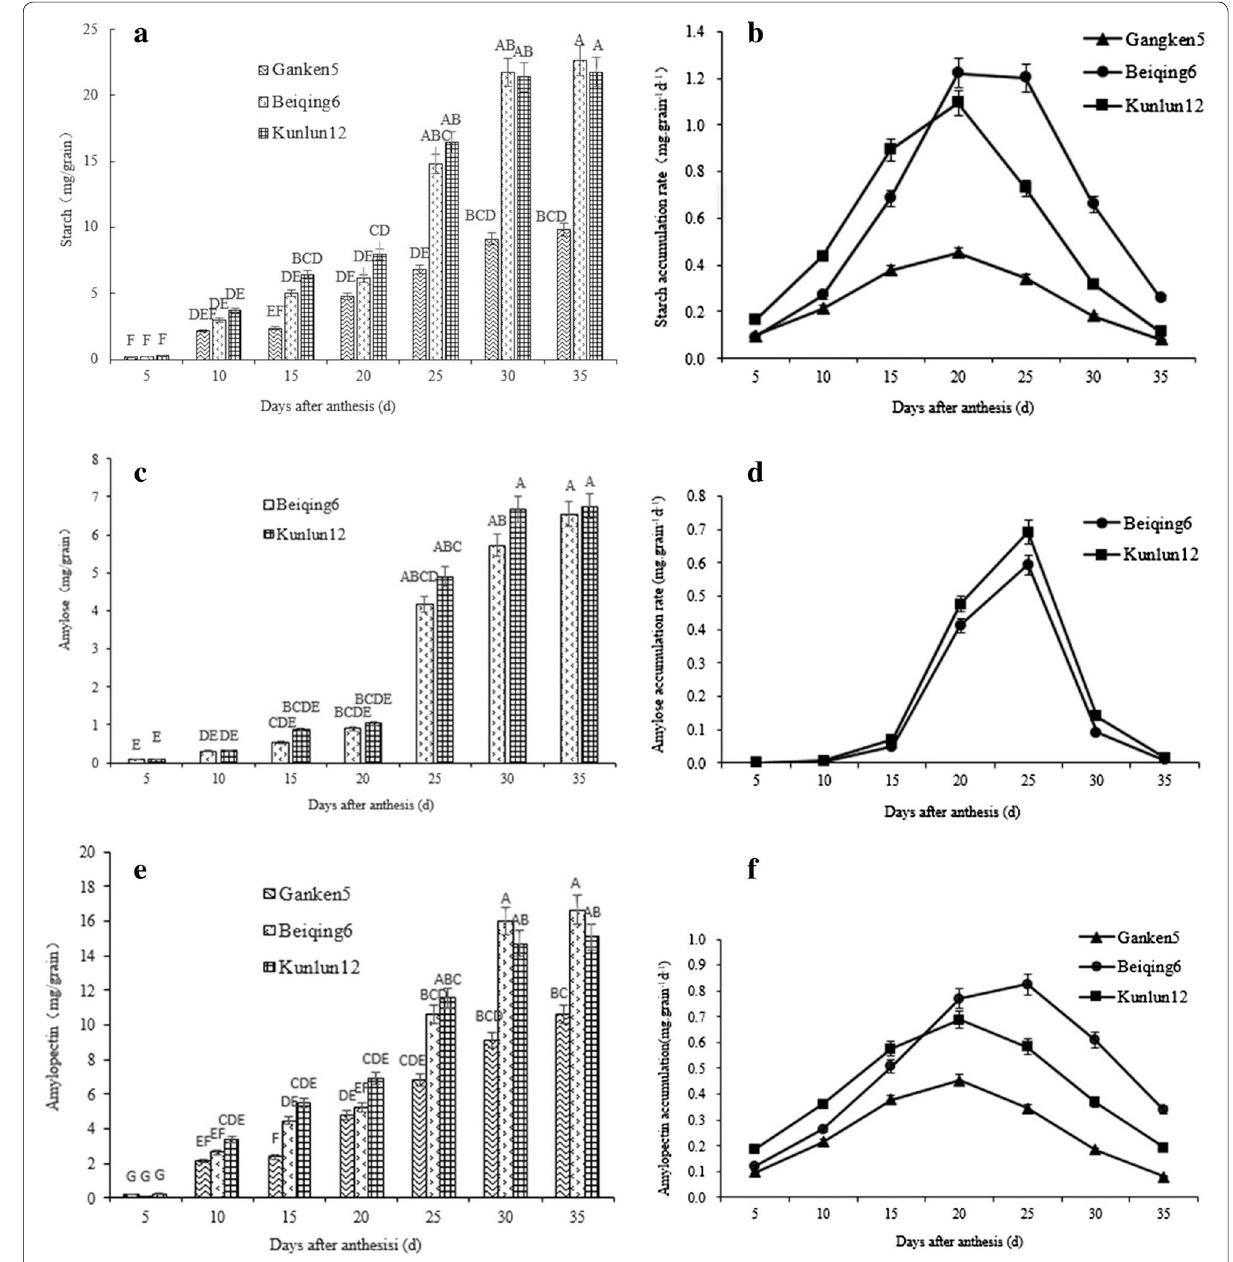
Fig. 2 Temporal changes in the content and accumulation rate in three hulless barley cultivars. a Starch content; b Starch accumulation rate; c Amylose content; d Amylose accumulation rate; e Amylopectin content; f Amylopectin accumulation rate. Bars with different letters are significantly different at the 0.01 level of significance. Error bars indicate standard